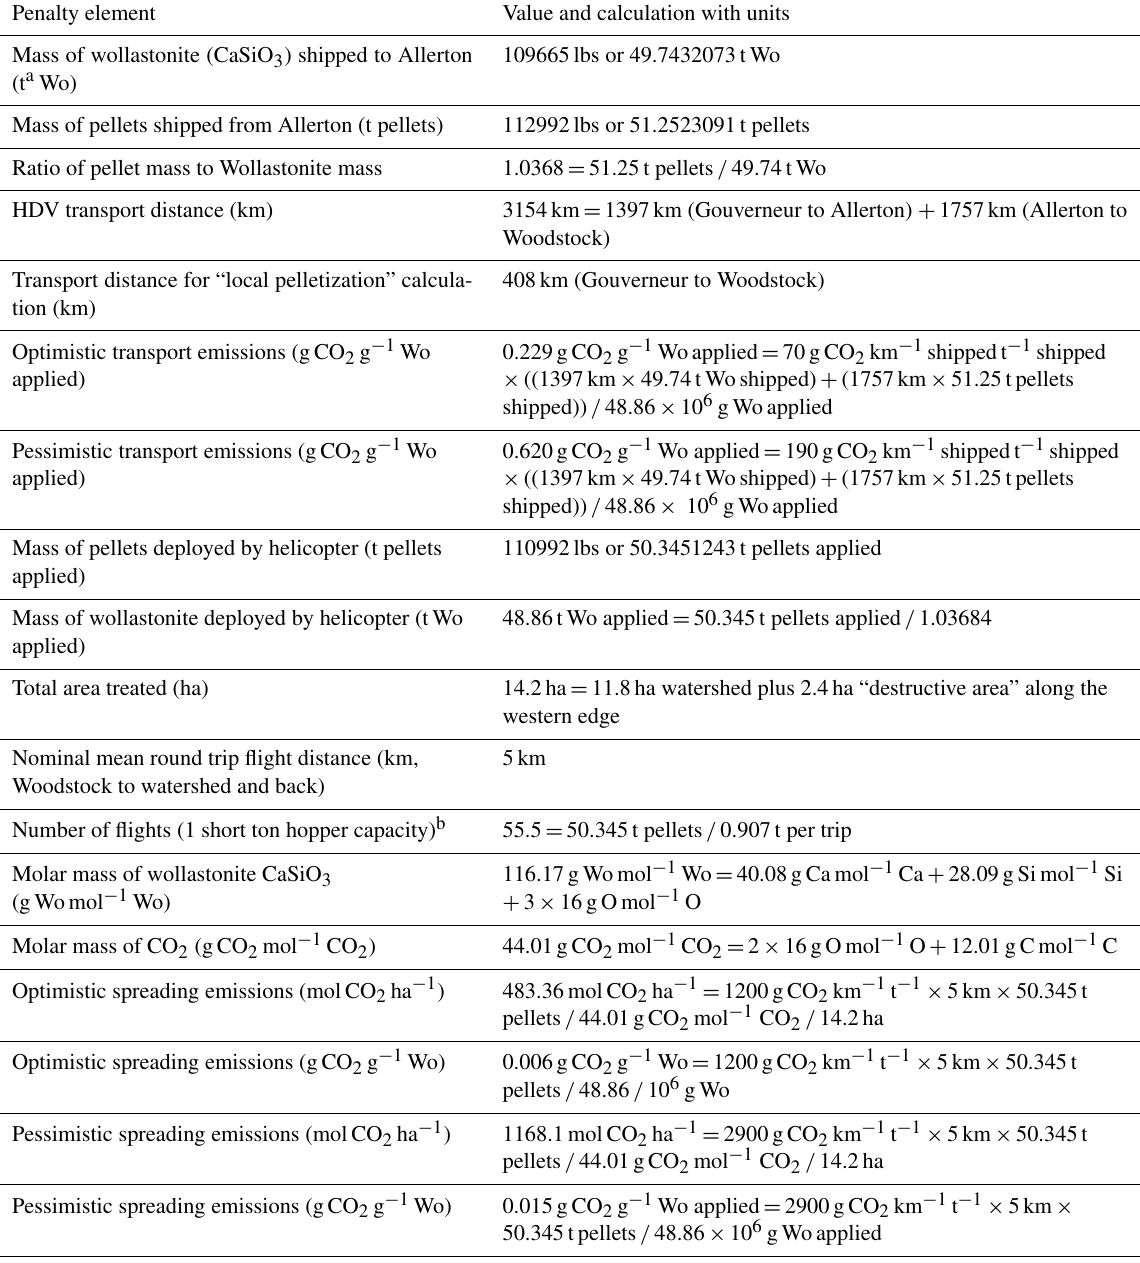
Table 2. Logistical penalty calculations for the Hubbard Brook wollastonite treatment. Penalty element Value and calculation with units Mass of wollastonite (CaSiO 3 ) shipped to Allerton 109665lbs or 49.7432073tWo Mass of pellets shipped from Allerton (t pellets) 112992lbs or 51.2523091t pellets Ratio of pellet mass to Wollastonite